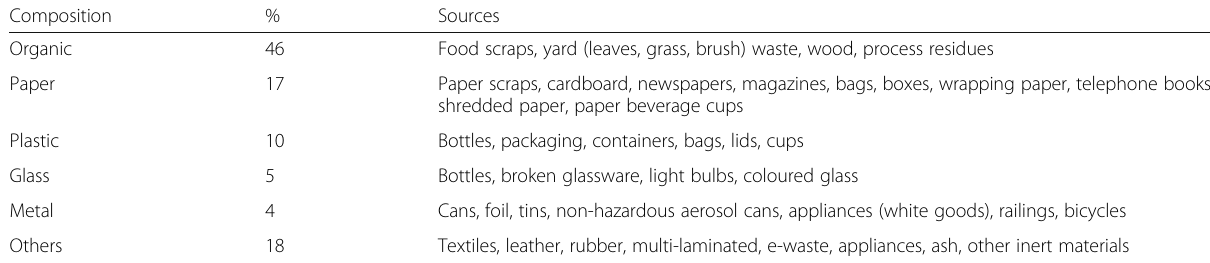
Table 1 Typical global waste composition and sources [11] Composition